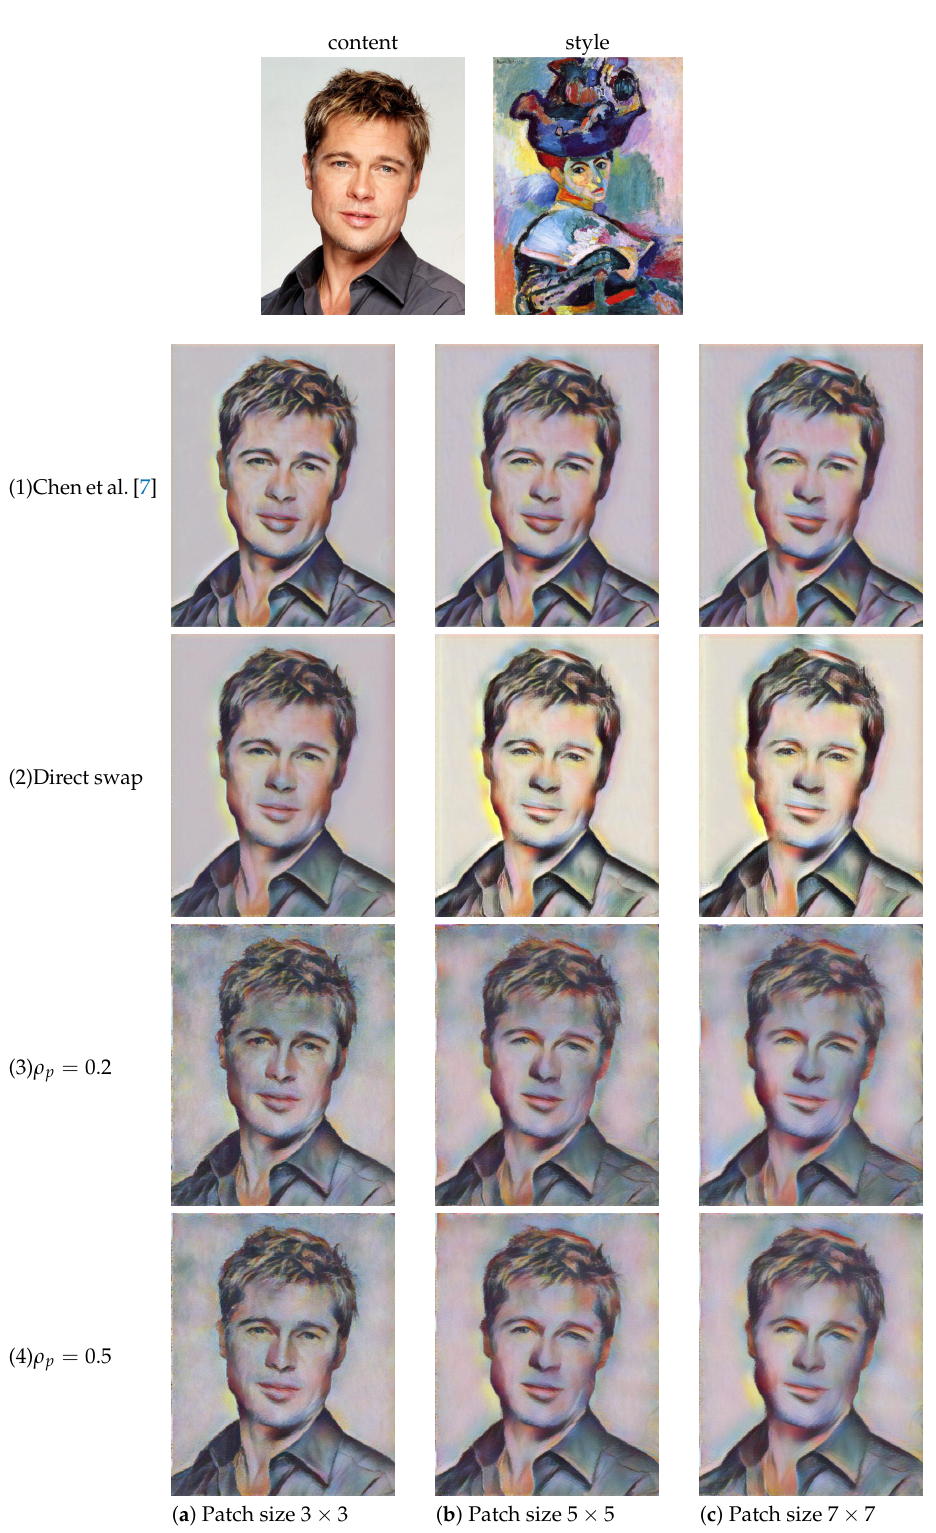
Figure 8. Results comparison with Chen et al., direct swap and our method under different patch